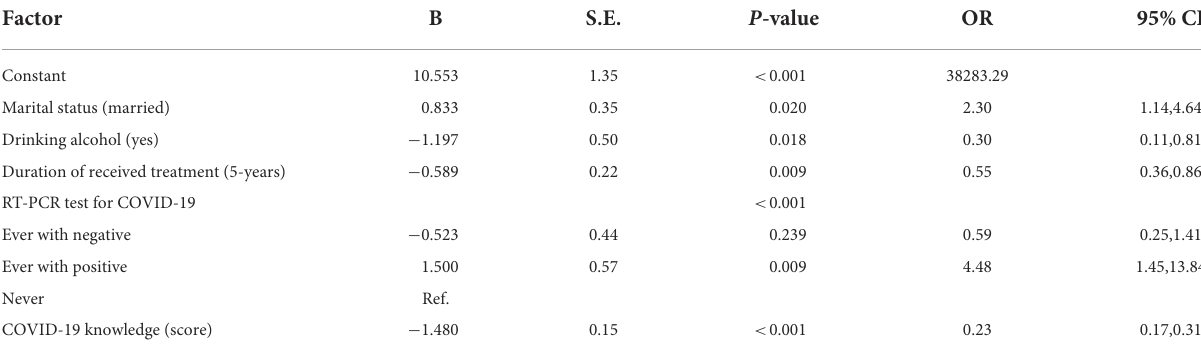
TABLE 4 Association between the COVID-19 knowledge and mental health problem by multiple logistic